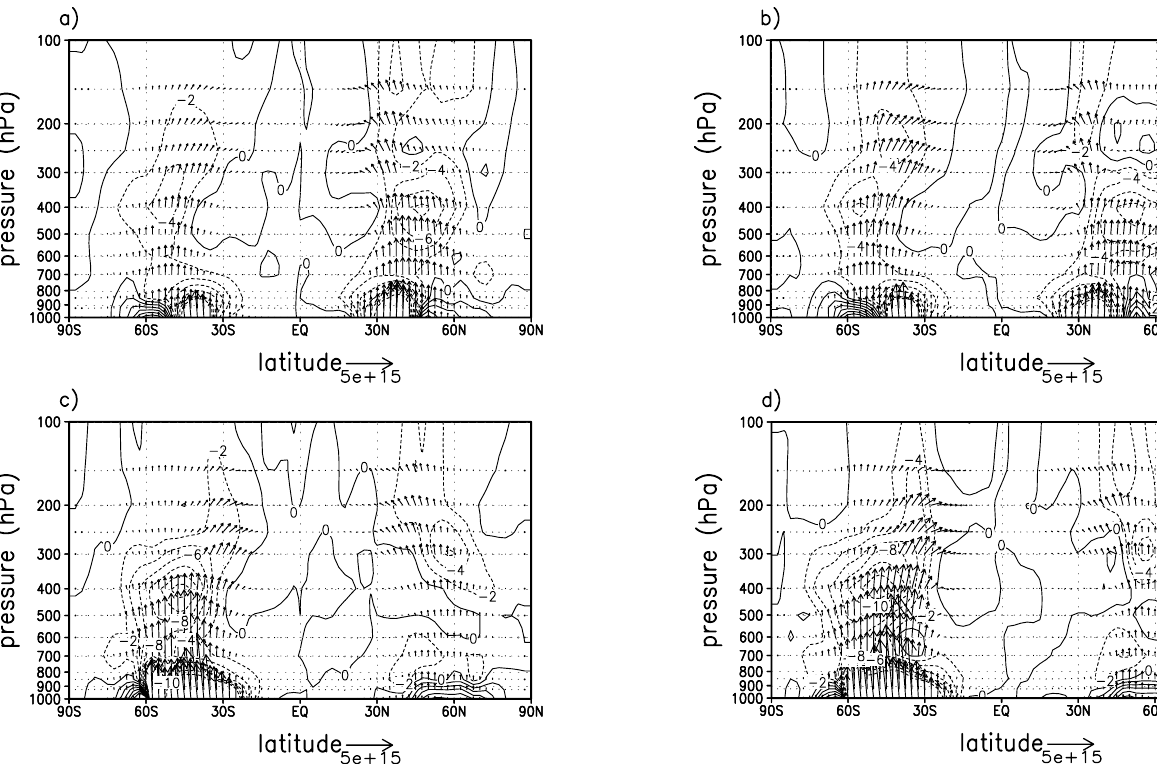
Fig. 14. Zonally-averaged EP cross sections for (a) January 1996, (b) January 1998; (c) July 1995, and (d) July 1997. The contour interval is 5.0 × 10 15 m 3 . The horizontal arrow scale for EP flux in units of m 3 is indicated at bottom